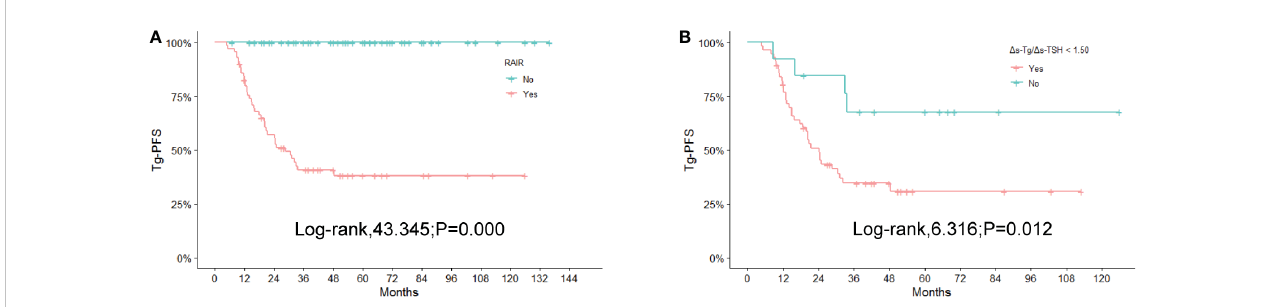
FIGURE 5 Kaplan-Meier curves for Tg-PFS (A) between non-RAIR and RAIR patients, (B) between RAIR patients with 1.50 of D s-Tg/ D s-TSH as the cutoff value. RAIR, radioiodine refractory; Tg-PFS, thyroglobulin progression-free survival.